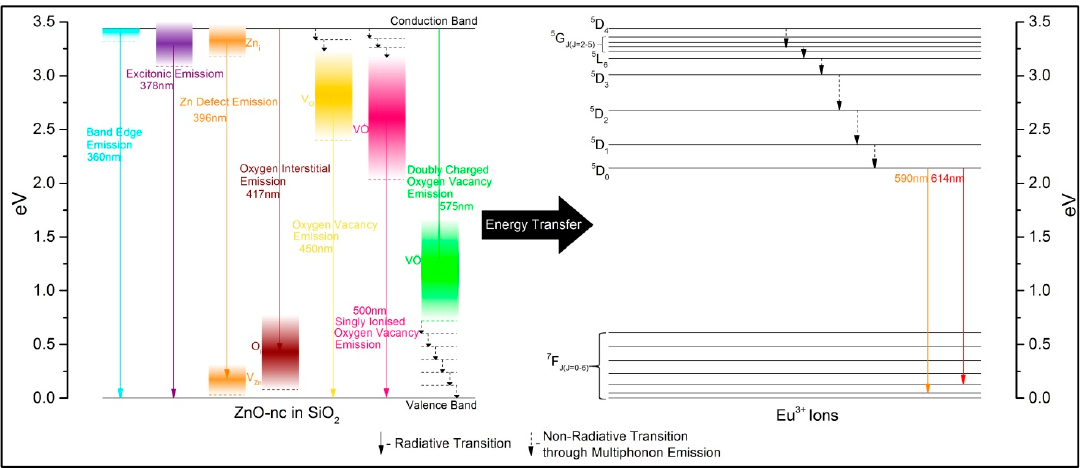
Figure 1. Energy band diagram showing the energy transfer from ZnO-nc to Eu 3+ ions in SiO 2 together with the various transitions corresponding to the emissions from ZnO-nc and Eu 3+ ions.